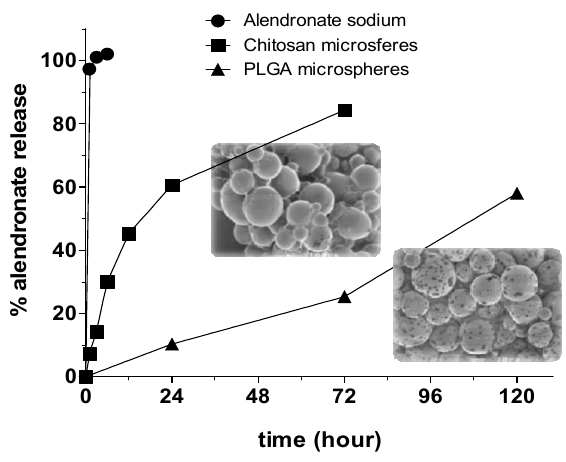
Figure 4. Alendronate release profiles obtained from alendronate sodium powder and alendronate loaded chitosan and PLGA microspheres. Modified with permission from Informa Healthcare